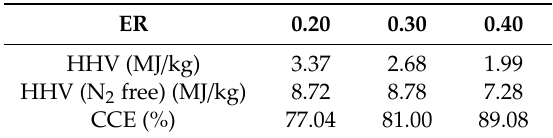
Table 5. E ff ects of ER on higher heating value (HHV) and carbon conversion e ffi ciency (CCE) at a gasification temperature of 850 ◦ C.